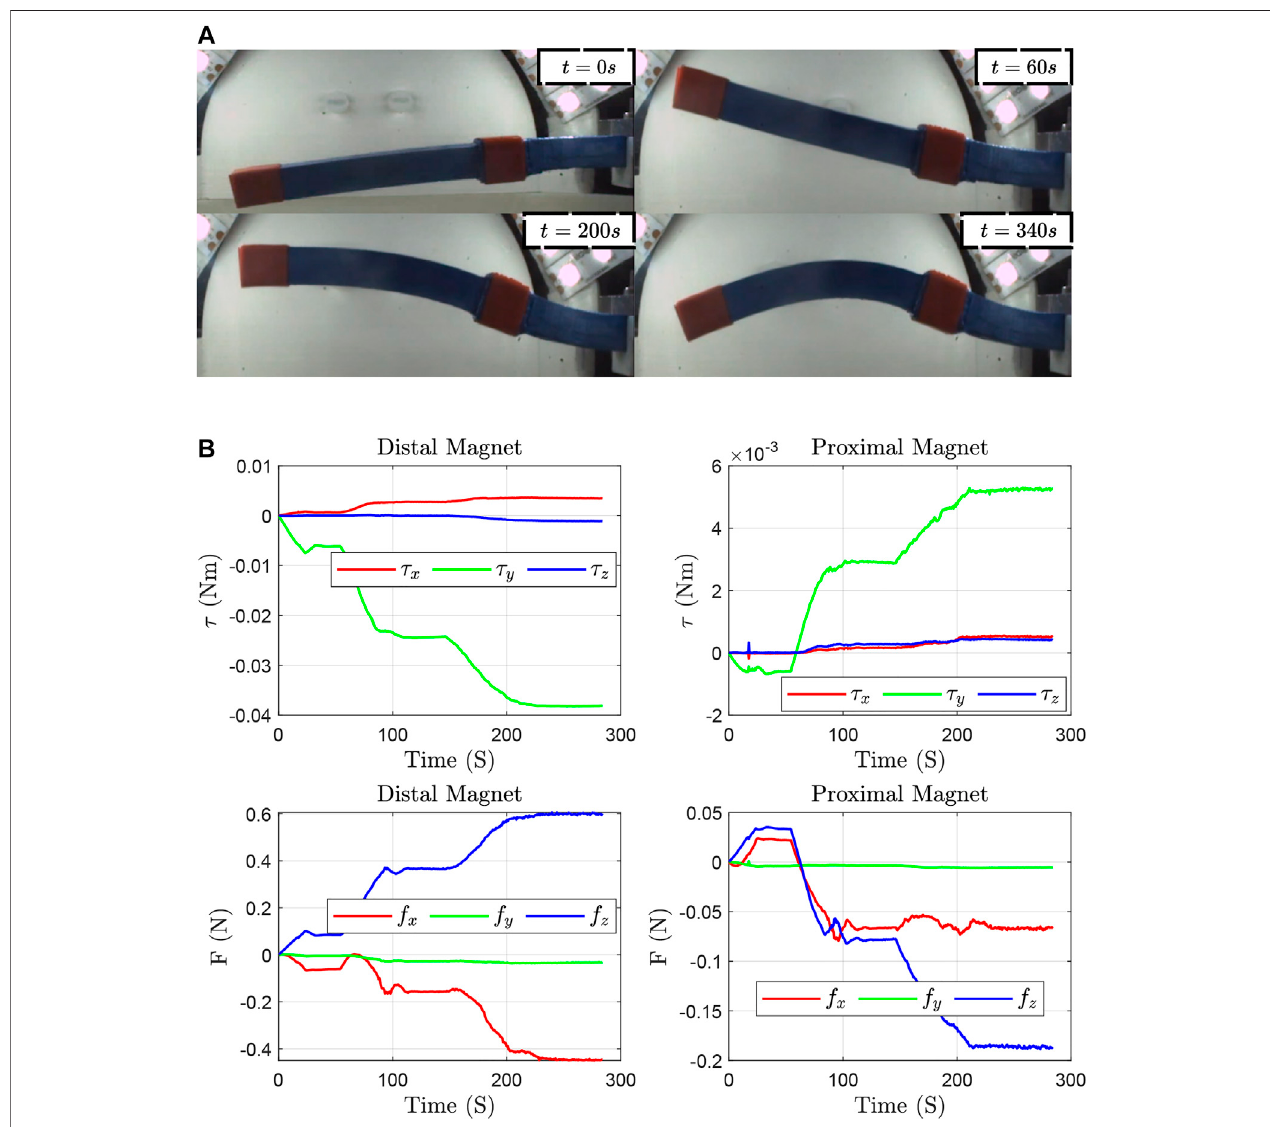
FIGURE 10 | (A) : Initial and time-evolved con fi gurations. (B) : Applied torques and forces on the distal and proximal magnets.